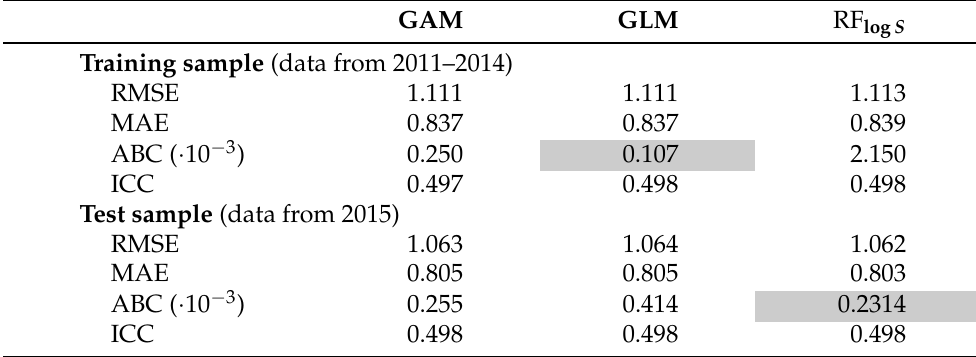
Table 5. Comparison of the total predicted claim severity GOF and GOL across the GAM, GLM, and RF models in the training and samples for log S